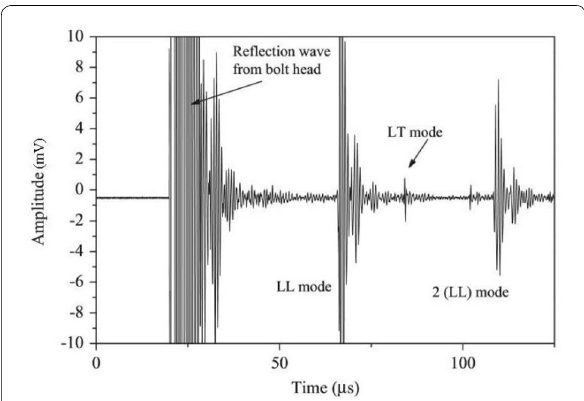
Figure 11 Mode-converted ultrasound from bolt specimen [6]